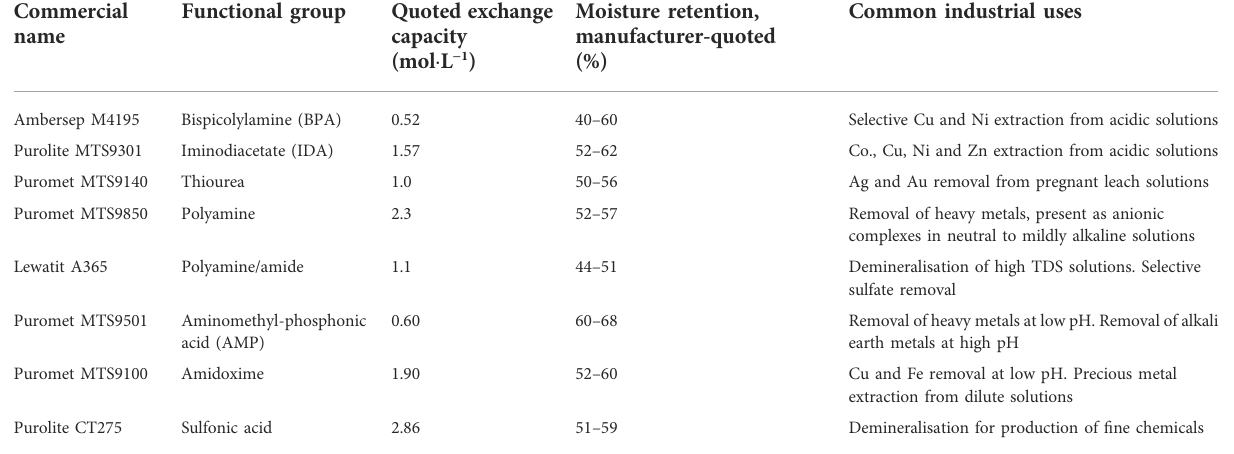
TABLE 1 Overview of basic physicochemical properties of the resins used in these